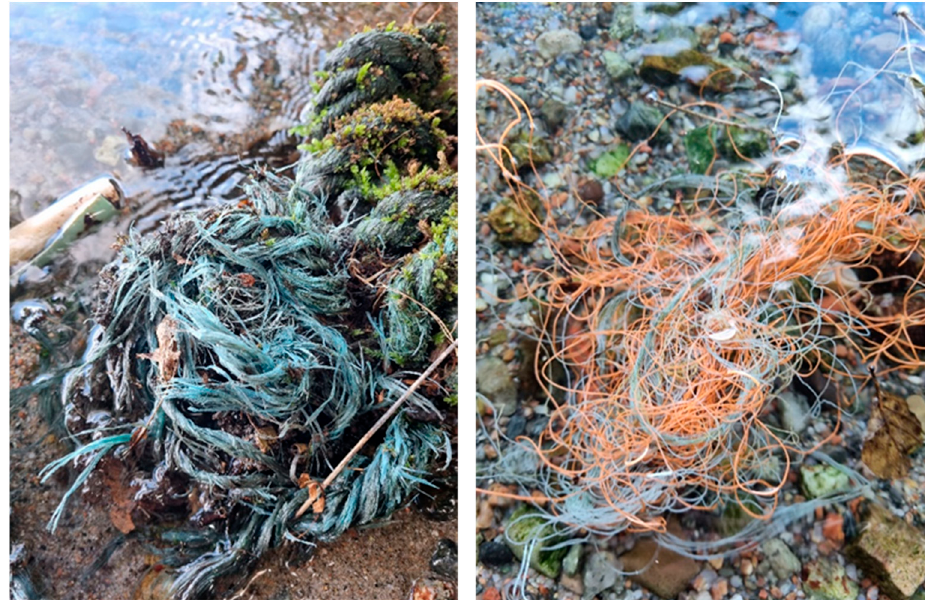
Figure 1. Parts of abandoned fishing nets found on a beach in southern Norway (Hessness, August 2022).